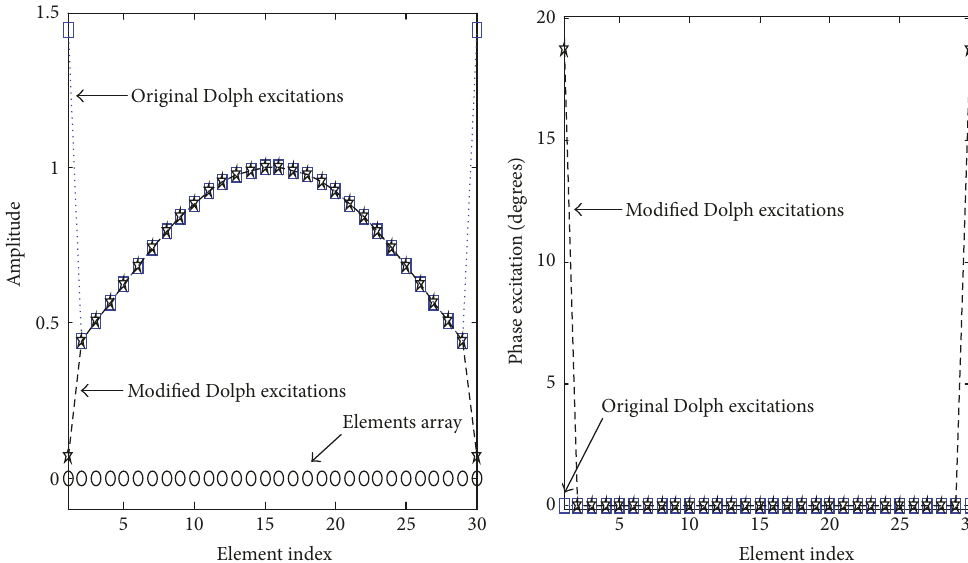
Figure 5: Amplitude and phase distributions of the original Dolph-Chebyshev array and the proposed arrays for 𝑁 = 30 and 𝑑 = 𝜆/2 .